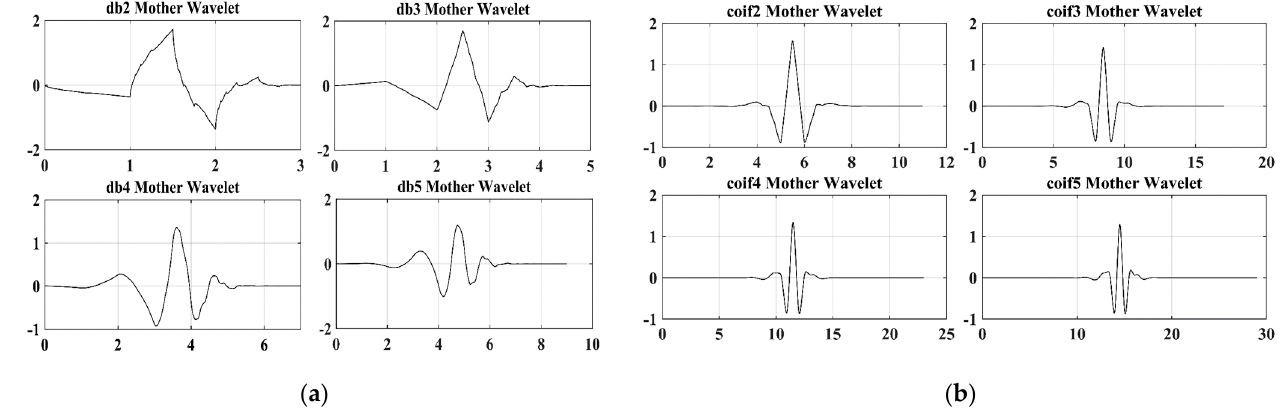
Figure 3. Mother wavelets at different levels: ( a ) Four mother wavelets of db family; ( b ) Four mother wavelets of coif family.